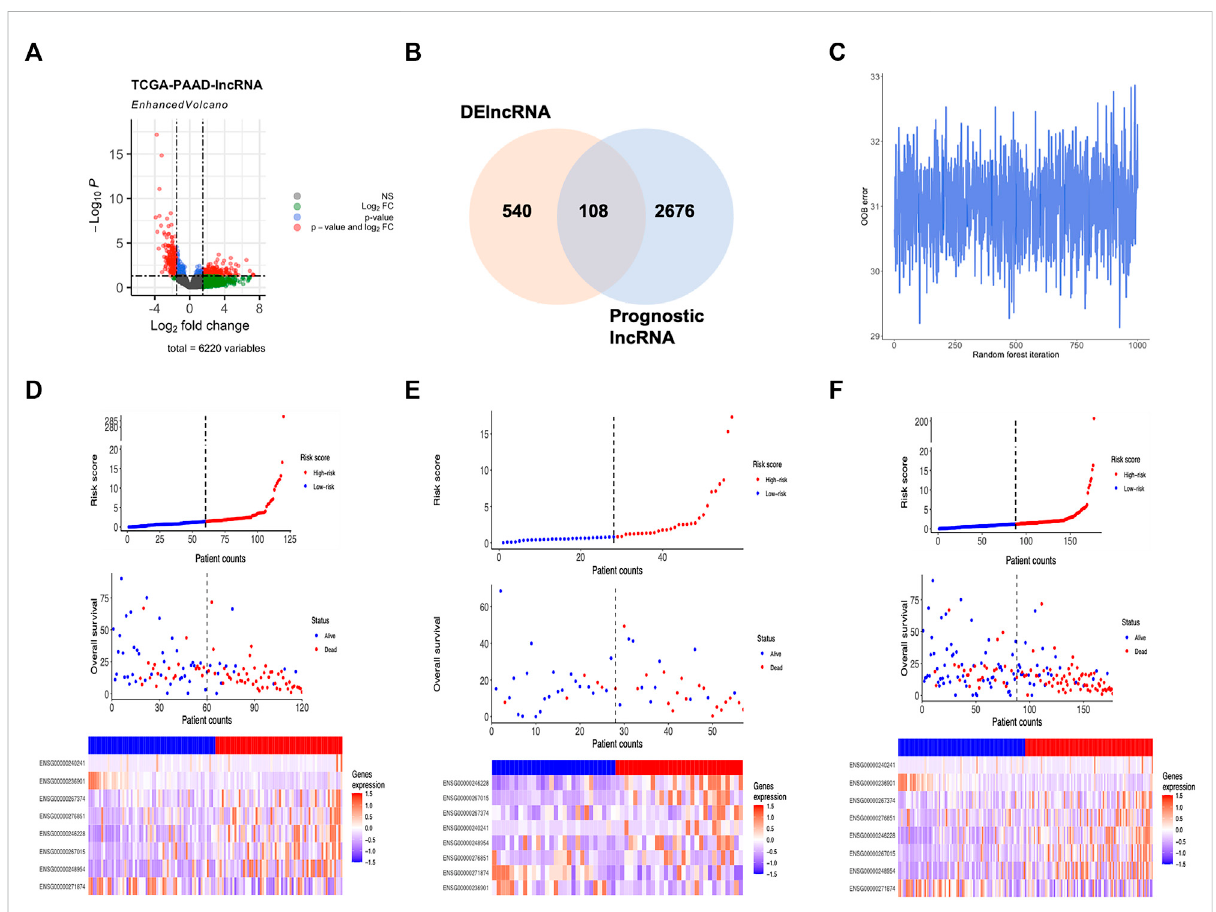
FIGURE 2 Development of lncRNA based molecular signature. (A) Volcano plot showed DElncRNAs identi fi ed from the TCGA-PAAD dataset. (B) Venn diagram of candidate lncRNAs obtained by overlapping DElncRNAs and Cox positive lncRNAs in the training cohort. (C) OOB error in 1,000 iteration of the random survival forest regression. (D) Distribution of the lncRNA based signature and expression of component lncRNAs in training group. (E) Distribution of the lncRNA based signature and expression of component lncRNAs in testing group. (F) Distribution of the lncRNA based signature and expression of component lncRNAs in whole group.